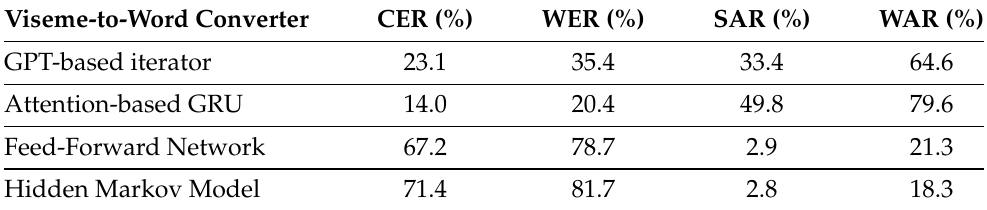
Table 6. Performance of viseme-to-word converters for Situation